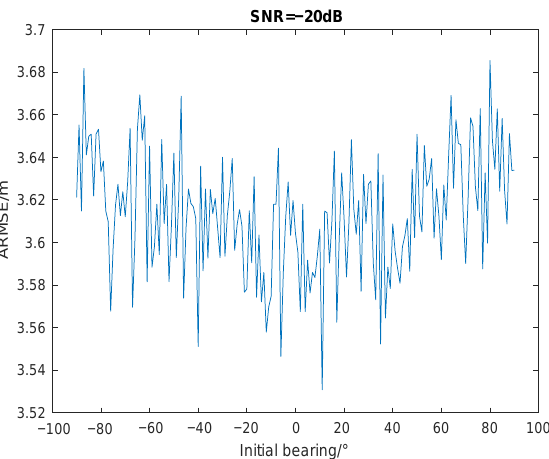
Figure 7. The variation in accuracy of range estimation when initial bearing is